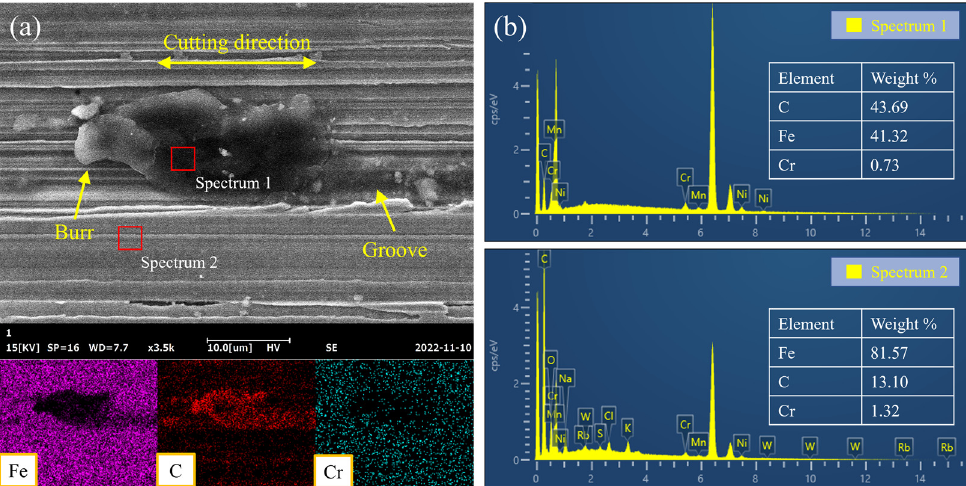
Figure 7. ( a ) Morphology and element map of the cavity and ( b ) corresponding EDS analysis for the form-ground samples.